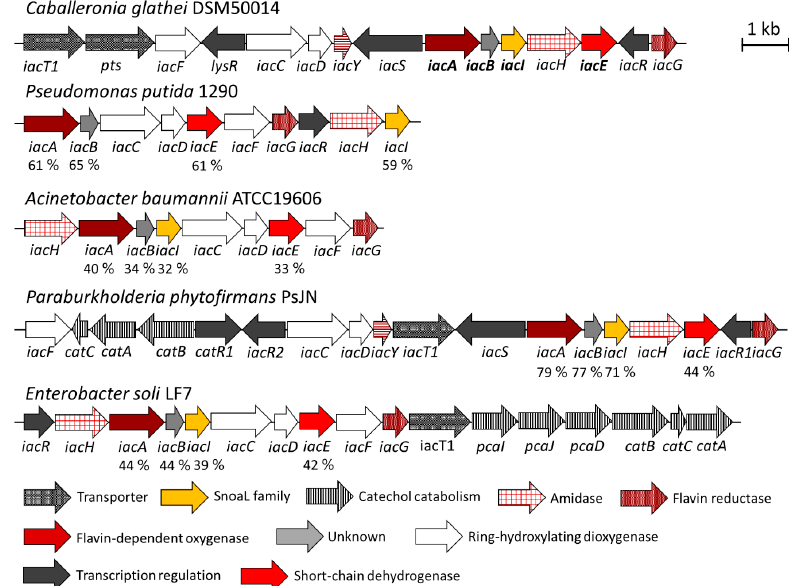
Figure 2. Distribution of iac and related genes in the genomes of known IAA-degrading microorganisms and C. glathei DSM50014. The genes of the enzymes that were studied in this work are highlighted in bold. Accession numbers of the proteins studied in this work are: IacA–WP_035925671, IacB–WP_035925668, IacI–WP_035925861, IacE–WP_035925663. The identity percentage between homologous genes that were studied in this report are also indicated.